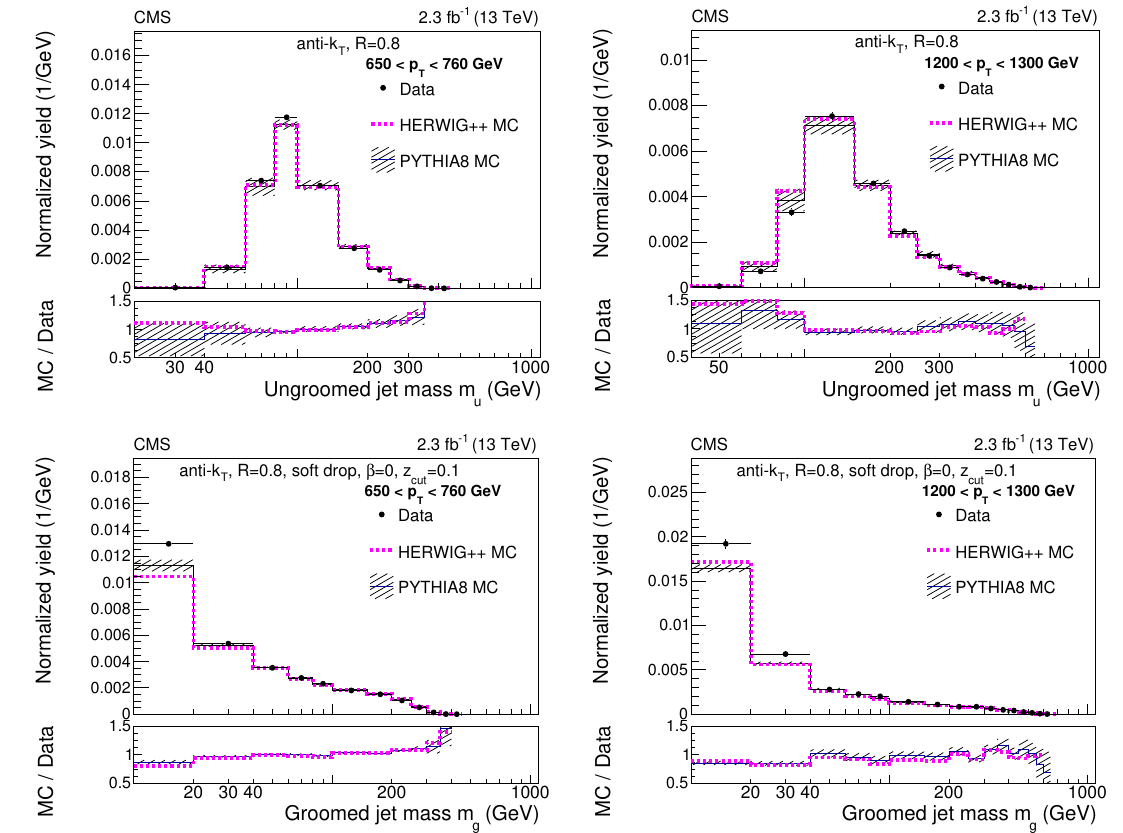
Figure 3 . Comparison of data to MC simulation for ungroomed jets (top) and groomed jets (bottom) for two p T bins at the detector level. The data and their statistical uncertainties are shown by the black points with the error bars. The pythia 8 results before the unfolding are shown in the shaded histograms, including experimental and theoretical systematic uncertainties. The herwig++ results before unfolding are shown without uncertainties as a dashed magenta